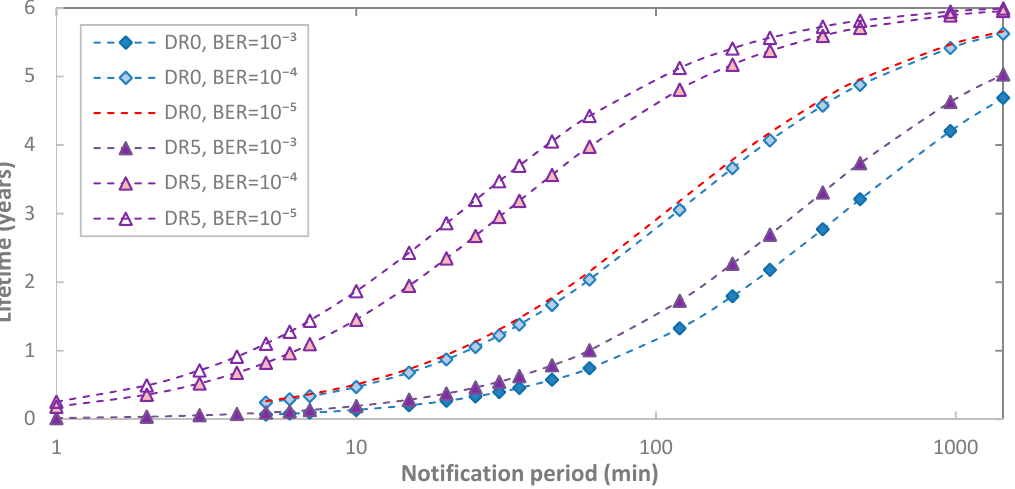
Figure 16. Impact of BER on end-device lifetime in acknowledged transmission, as a function of T Notif , for different DR settings, and for p coll = 0.